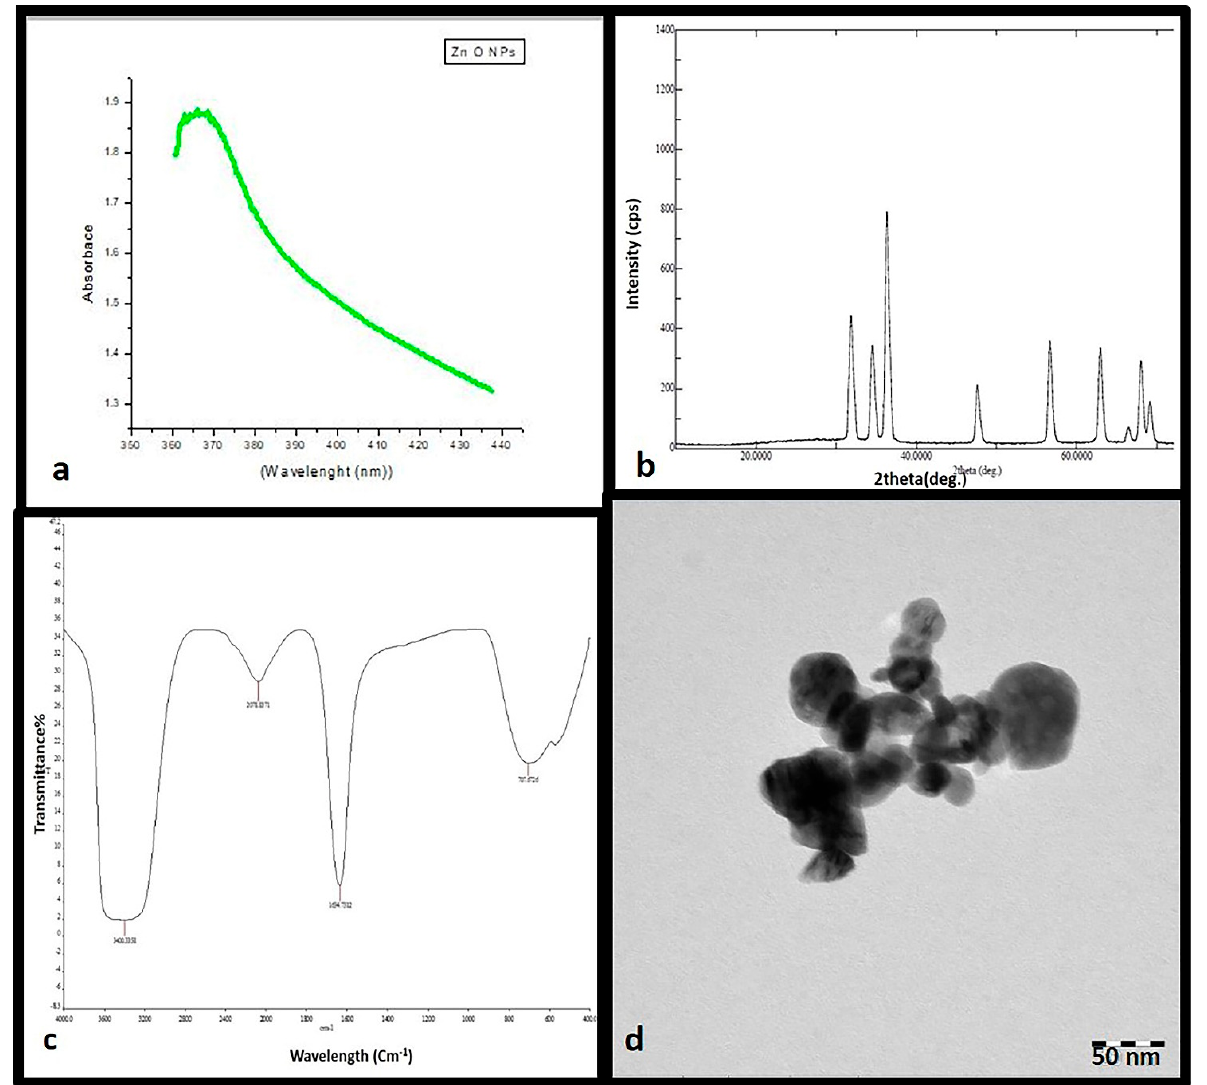
Figure 1. Ultraviolet–visible absorption spectrum of zinc oxide nanoparticles (ZnO NPs) with a plasmon band at 380 nm ( a ). XRD patterns ( b ). Fourier-transform infrared spectroscopy profile showing four peaks at 704, 1634, 2078, and 3400 cm − 1 ( c ). Transmission electron microscope image of ZnO NPs ( d ).